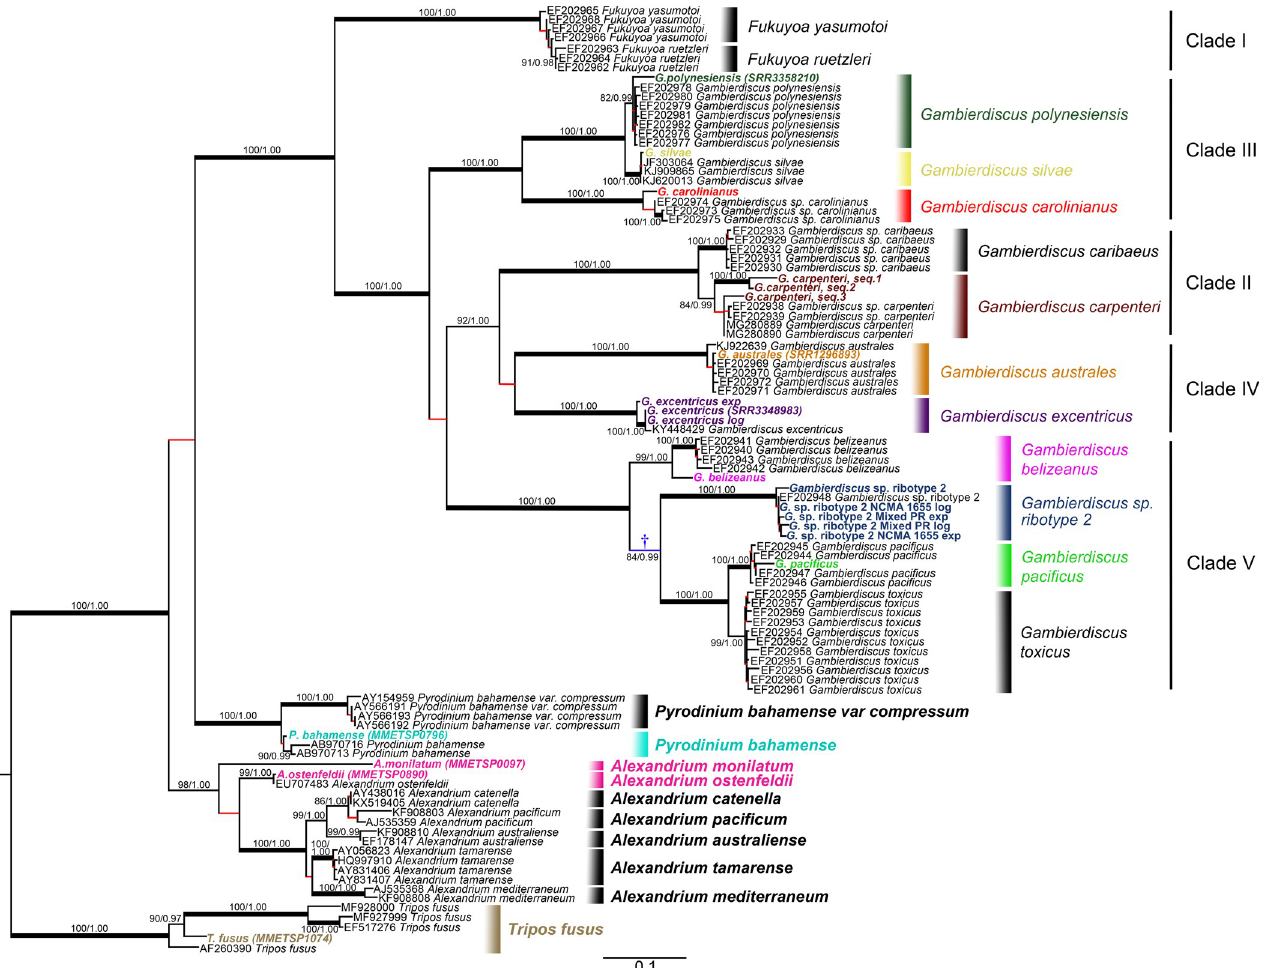
Fig 1. Phylogenetic tree of Gambierdiscus using the large ribosomal subunit, D1 to D3, region. Maximum likelihood tree (generated by RAxML), supported by Bayesian analysis. Branches indicated in red are not supported (ML bootstrap � 80%; Bayesian posterior probability < 1). Bolded taxa are sequences obtained from high-throughput transcriptomics. Those with an identifier following the name resulted from transcriptomes pulled from NCBI. Branch with lower support (†) indicates a possible single common ancestor of G . belizeanus , G . pacificus , and G . sp. Ribotype 2. Nucleotide tree with 99 taxa. There are 0.1 substitutions per